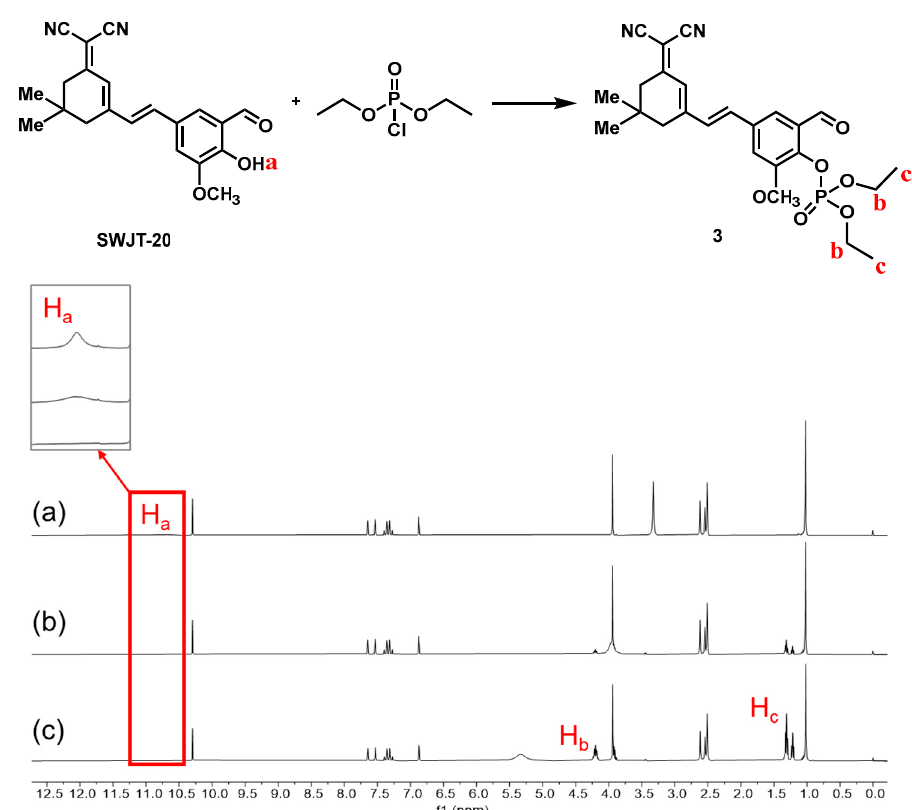
Figure 3. The proposed reaction mechanism and 1 H NMR spectra of ( a ) SWJT-20 and ( b ) SWJT-20 + 0.5 eq. DCP ( c ) SWJT-20 +1.0 eq. DCP in DMSO- d 6 .